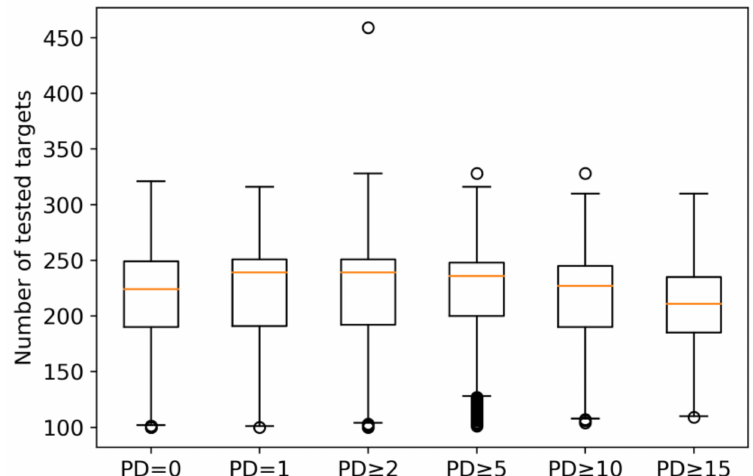
Figure 1. Boxplots report the distribution of assayed targets for compounds with di ff erent promiscuity degrees. PD = 0 and PD = 1 denote compounds that were consistently inactive in all assays and active against a single target, respectively. Boxplots show the smallest value (bottom line), first quartile (lower boundary of the box), median value (red line), third quartile (upper boundary of the box), largest value (top line), and outliers (points below the smallest or above the largest value).